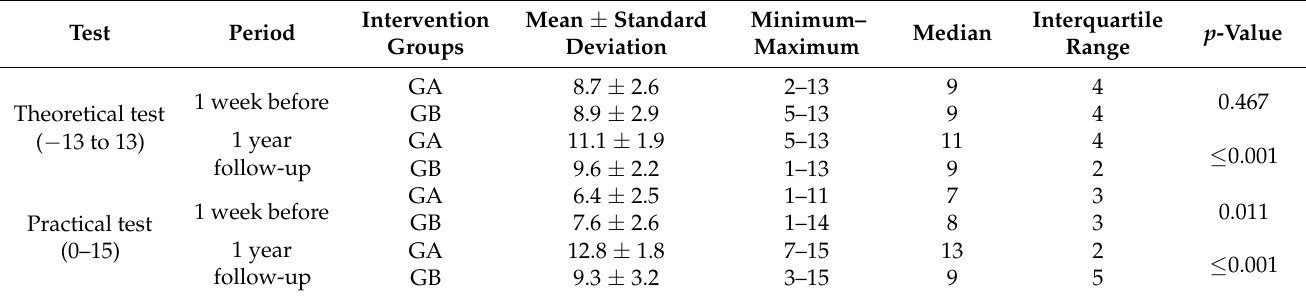
Table 1. Values obtained in theoretical and practical tests.